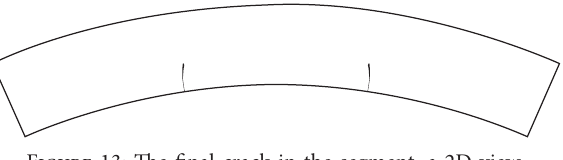
Figure 13: The final crack in the segment, a 2D view.